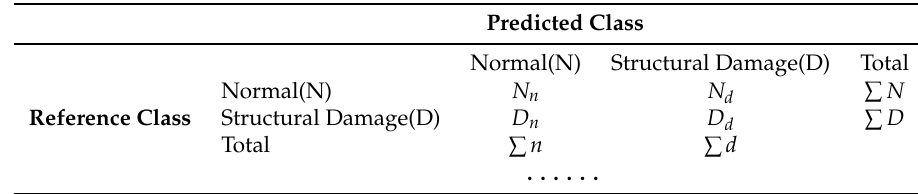
Table 1. Counting rules for the numbers of the variables used in the F 1 evaluation measurements for Structural Damage Monitoring